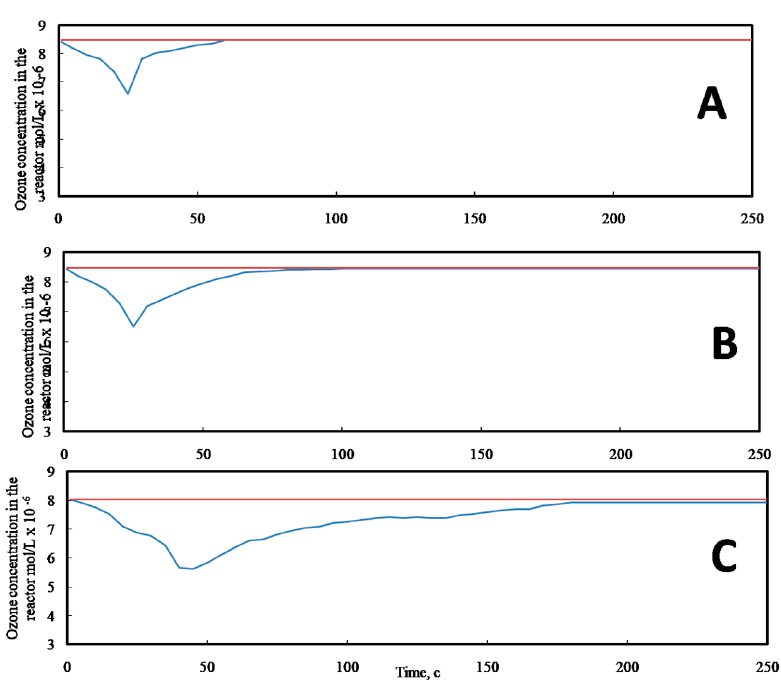
Figure 3. Ozone uptake curves for MPHDPE membranes before and after ozonation: ( A ) blank test without the sample, ( B ) pristine HDPE, and ( C ) mesoporous HDPE membrane (orange line—concentration of ozone in the in-flow; blue line—concentration of ozone in the off-gas).